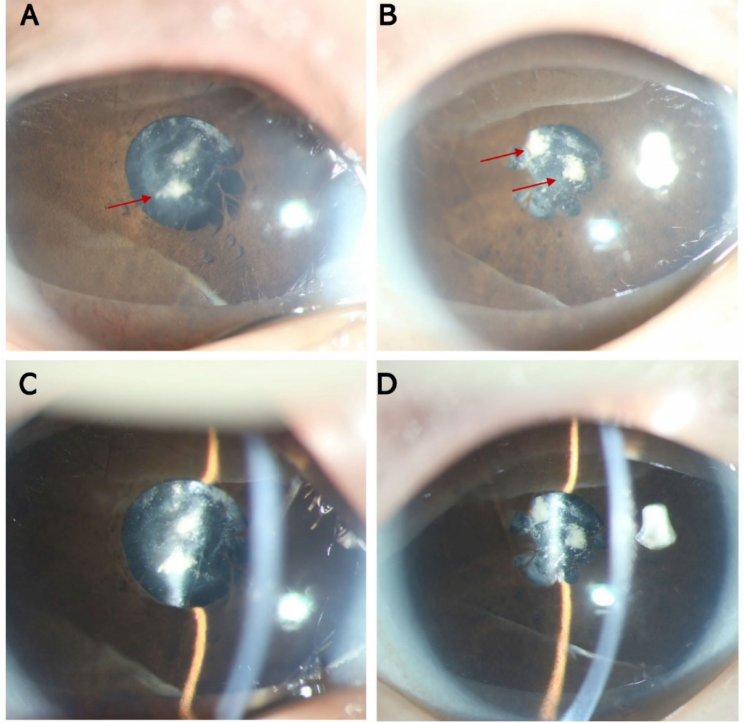
Figure 1. Anterior segment photographs of the patient with WARBM. ( A ) Anterior segment photograph using diffuse illumination of the right eye showing the persistent papillary membrane and lens